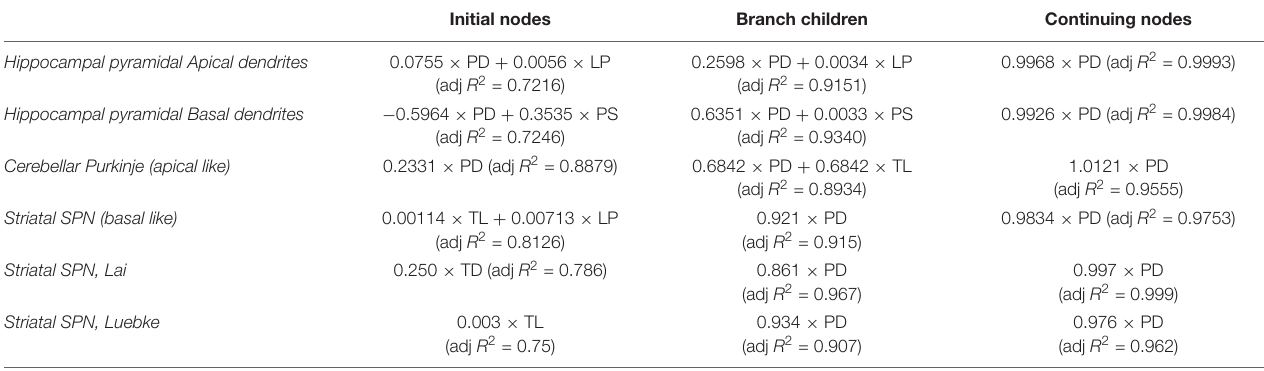
TABLE 4 | Predictive diameter equations.